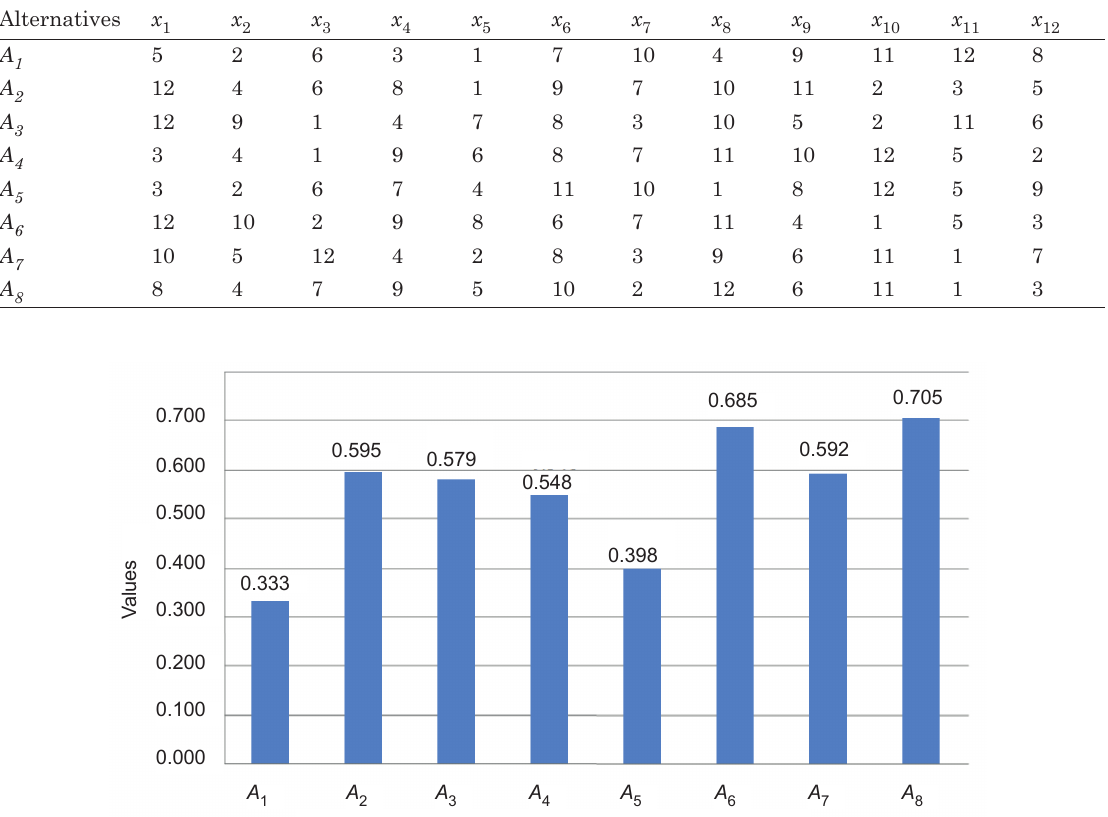
table 4. the ways to locate high-rise buildings in the urban structure of Vilnius: the initial decision- making matrix with the values